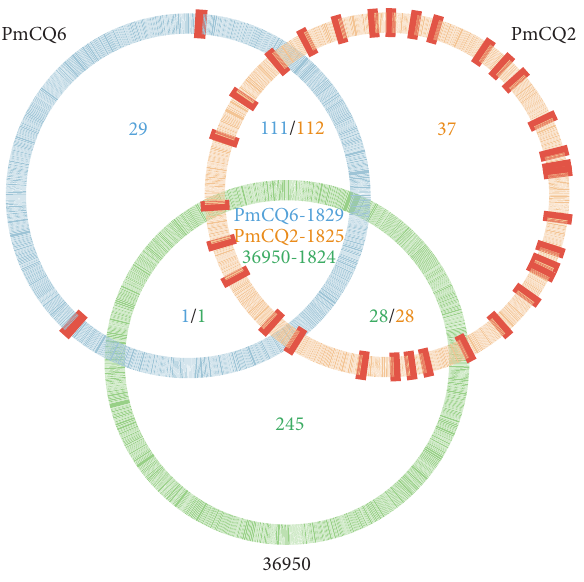
Figure 5: Venn diagram illustrating the number of putative proteins associated with each organism and the number shared with the intersecting organism. Red thick marks on each circle represent the location of the unique proteins (BLAST score ratio less than 0.4) on the PmCQ2 and PmCQ6 genome. Chromosomal comparison: jacinth, PmCQ2; blue, PmCQ6; green,